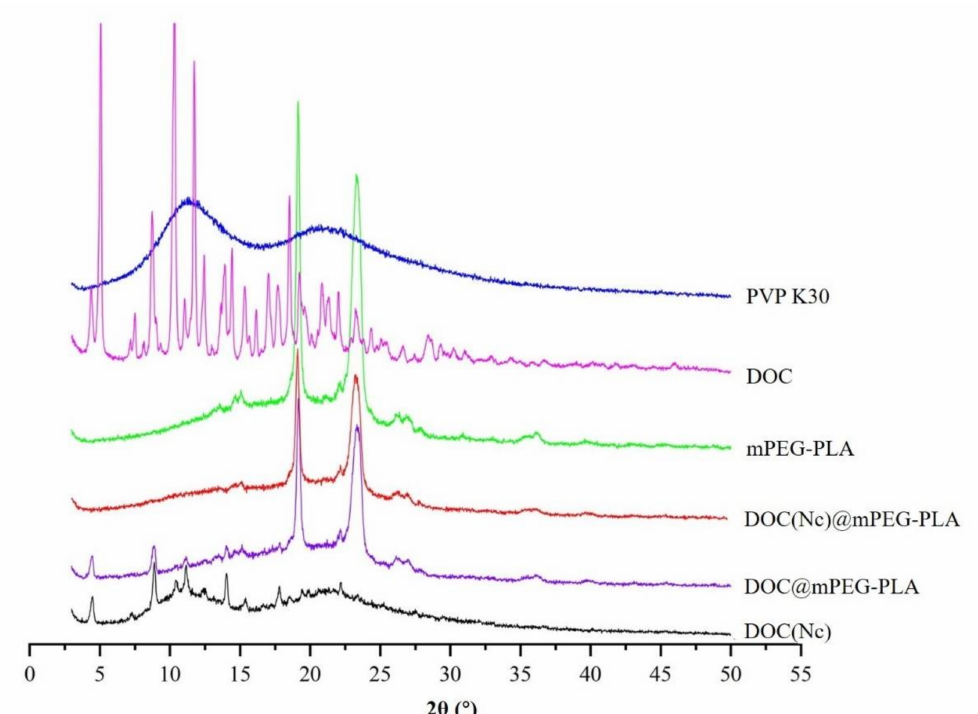
Figure 4. The XRD spectra of different